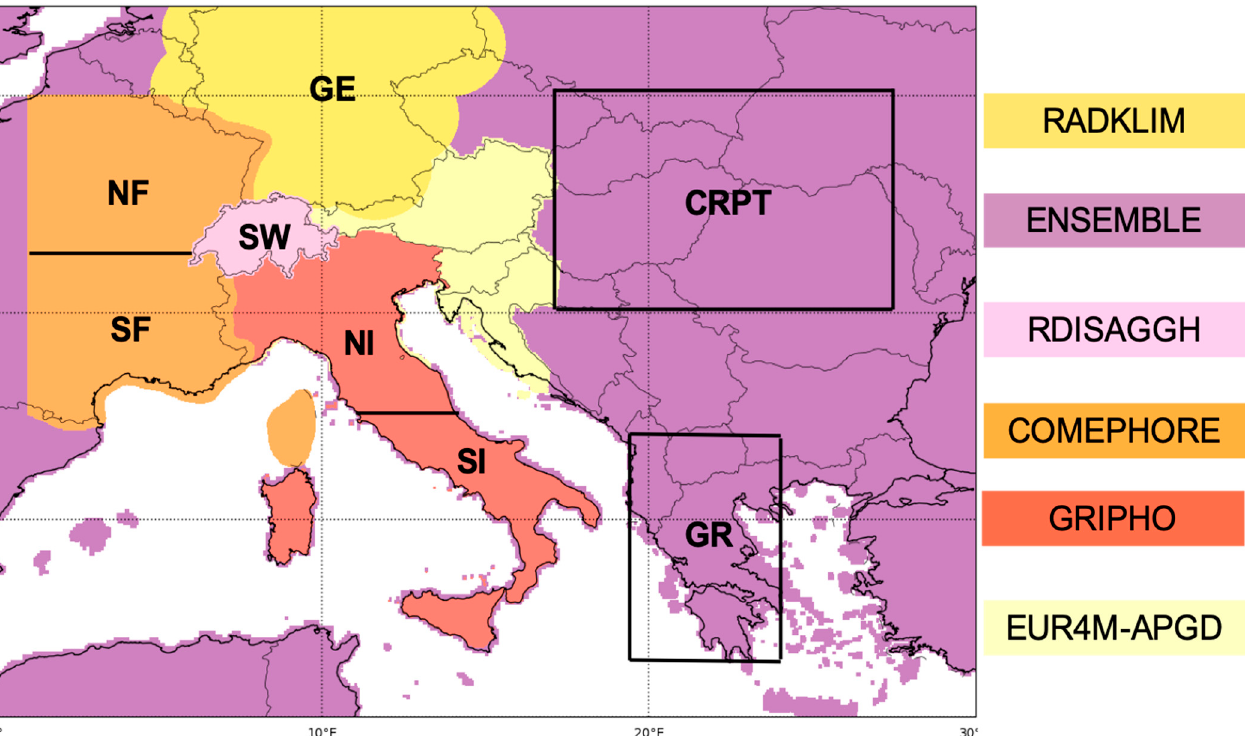
Figure 2. Observational dataset map used for the analysis. EURO4M-APGD (light pastel yellow), GRIPHO (light pastel red), COMEPHORE (orange), RdisaggH (pink), RADKLIM (yellow) and an Ensemble mean of HMR, PERSIANN-CCS, CHIRPS, and CMORPH (purple). EURO4M-APGD and ENSEMBLE are at a daily time scale, while the other datasets are at an hourly time scale. Domains used as evaluation target grids in the PDF analysis are labelled as follows: North and South France (NF, SF), North and South Italy (NI, SI), Switzerland (SW), Germany (GE), the Carpathians (CRPT), and Greece (GR).